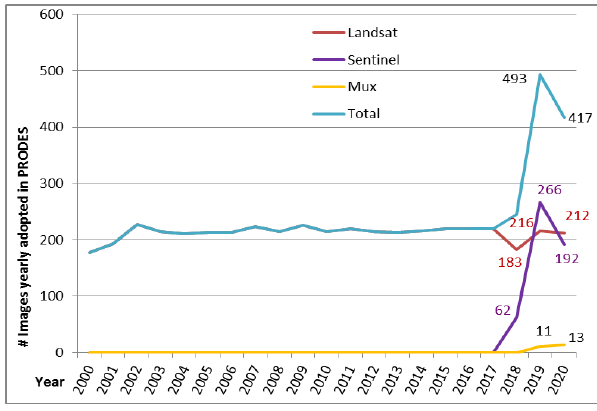
Figure 3 . Number of adopted images in PRODES project since 2000 according to sensor and year.